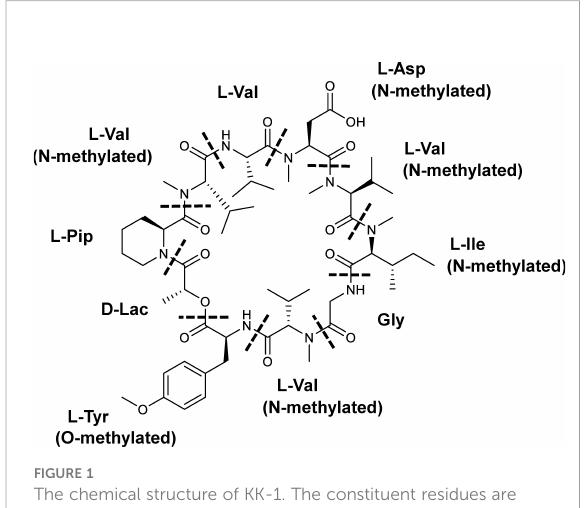
FIGURE 1 The chemical structure of KK-1. The constituent residues are separated by dotted lines: Lac, lactic acid residue; Pip, pipecolic acid residue; Val, valine residue; Asp, aspartic acid residue; Ile, isoleucine residue; Gly, glycine residue; Tyr, tyrosine